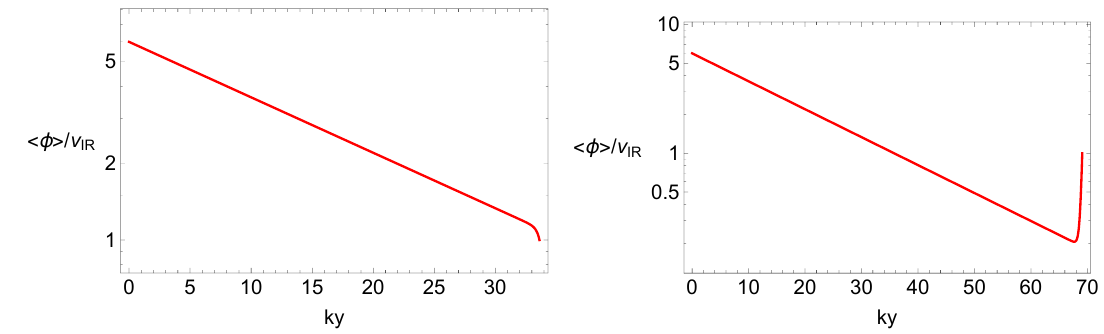
Figure 3 . (a) VEV of the Goldberger-Wise scalar in eq. (3.4) along the extra dimension if the radion is at the minimum of its potential, chosen as (cid:27) min same parameters as in (a) but for the radion at (cid:27) IR = 10 (cid:0) 30